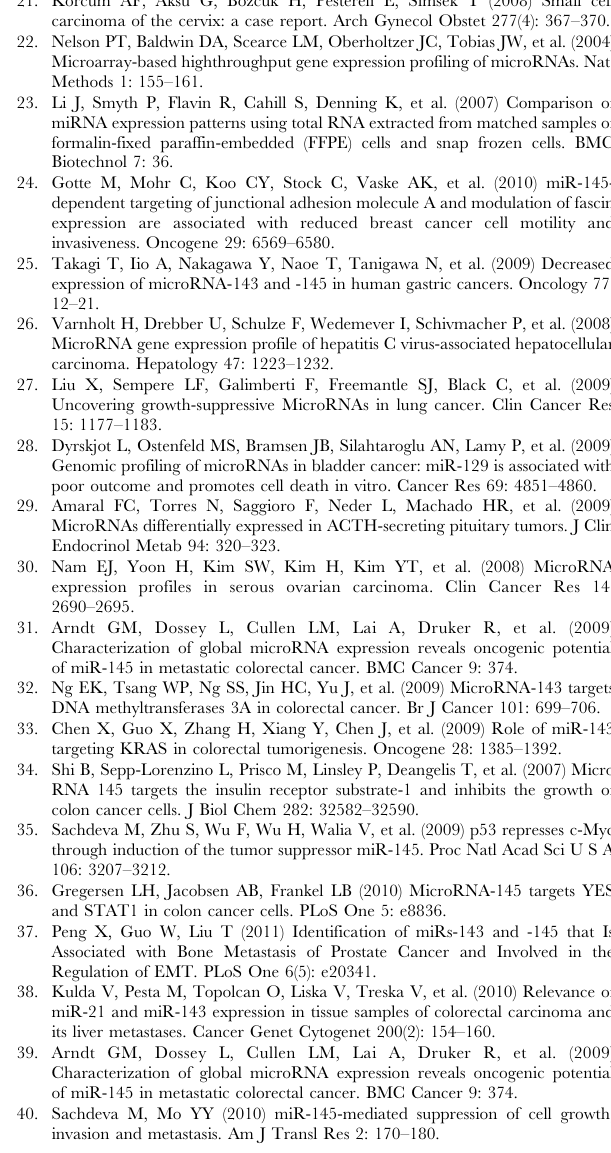
Table S1 Univariate and multivariate analysis of patient survival based on clinical and pathologic factors and miRNAs.